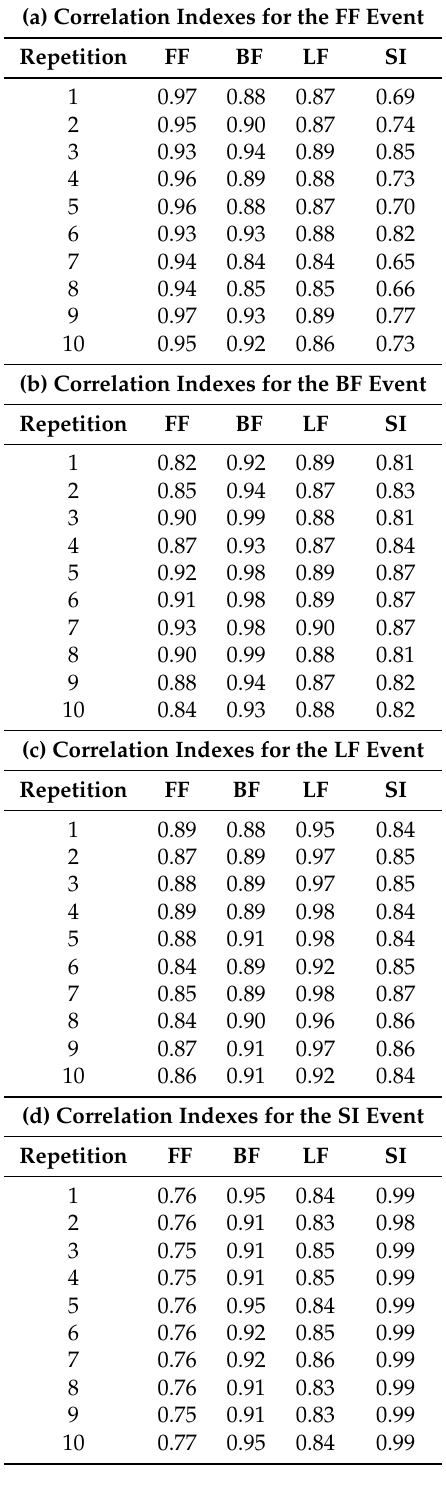
Table 2. Examples of correlation indexes.